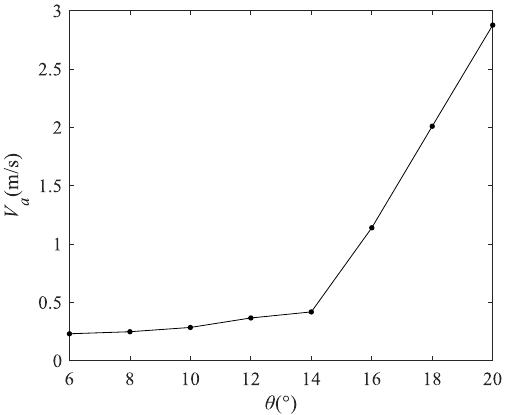
Figure 8. Average particle speed in 5 s at A = 4 mm, f = 16 Hz, θ = 6 – 20°, and a = 90°.